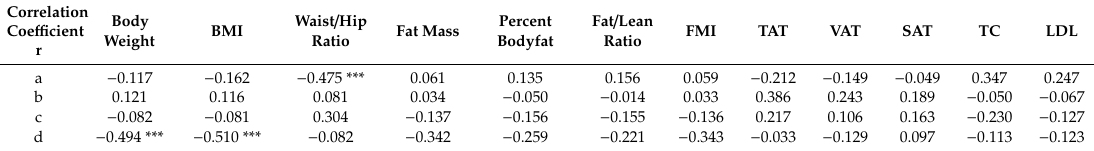
Table 2. Correlation between significantly changed metabolites and clinical characteristics (a, urocanic acid, b, guanidino valeric acid, c, 5-hydroxy-6-methoxyindole glucuronide, d,